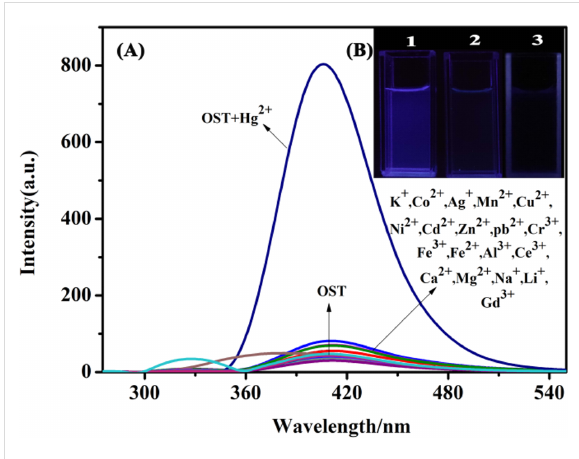
Figure 1: (A) Fluorescence spectra of OST ( c = 3.0 × 10 − 5 mol ∙ L − 1 ) upon the addition of various metal ions. (B) Fluorescent color change under ultraviolet light at 365 nm upon adding Hg 2+ ions. 1: OST + Hg 2+ solution, 2: OST + other ions, and 3: OST solution.